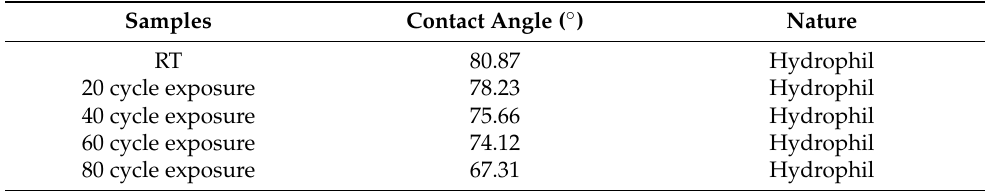
Table 4. Contact angle and nature of RT and thermal-cycling-exposure CFRP composite materials.